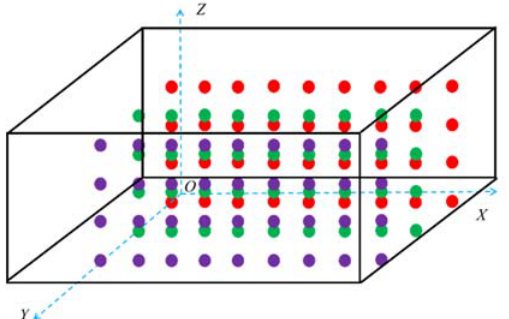
Figure 1. Layout of temperature measurement sensors in the granary. The colored circles in the figure indicates the location of the temperature measurement sensors. The green, red and purple circles in the figure form three planes parallel to XOZ .